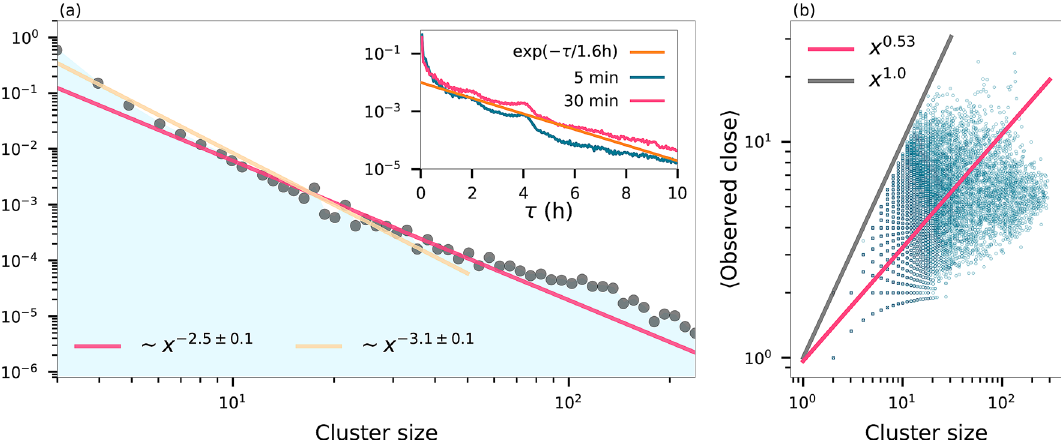
Figure 3. Statistics of social interaction networks generated from proximity data. Proximity is determined using Bluetooth by an app installed on smartphones distributed to a group of students at a Danish university 650 ). ( a ) The proximity data are split in one hour windows and in each window we identify the connected ( N ∼ components of the social interaction network and plot the distribution of cluster sizes. Power law fits over the x − 2.5 , whereas restricting the range to smaller cluster gives x − 3 . Parameter entire range of clusters gives ∼ ∼ errors from fits are smaller than the error due to range selection. Inset shows the distribution of the duration of time that people spent together. Blue curve allows gaps in the data of 5 min and pink allows 30 min gaps τ/τ 0 ) for times > 30 min yields characteristic times exp ( (see “Methods” section). Fitting these curves with ∼ − τ 0 1.5 h for the blue curve and τ 0 1.7 for the pink curve. ( b ) For each cluster, the plot shows the average ≈ ≈ number of students that had a strong Bluetooth signal with one another indicating proximity (cid:31) 2 m. A power x 0.5 . law fit of the data yields ∼